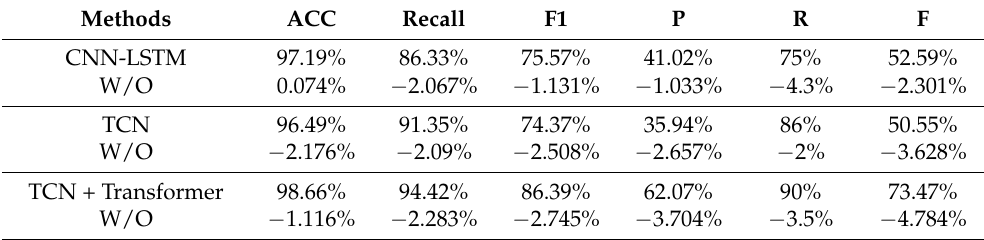
Table 7. Ablation experiment on weighted